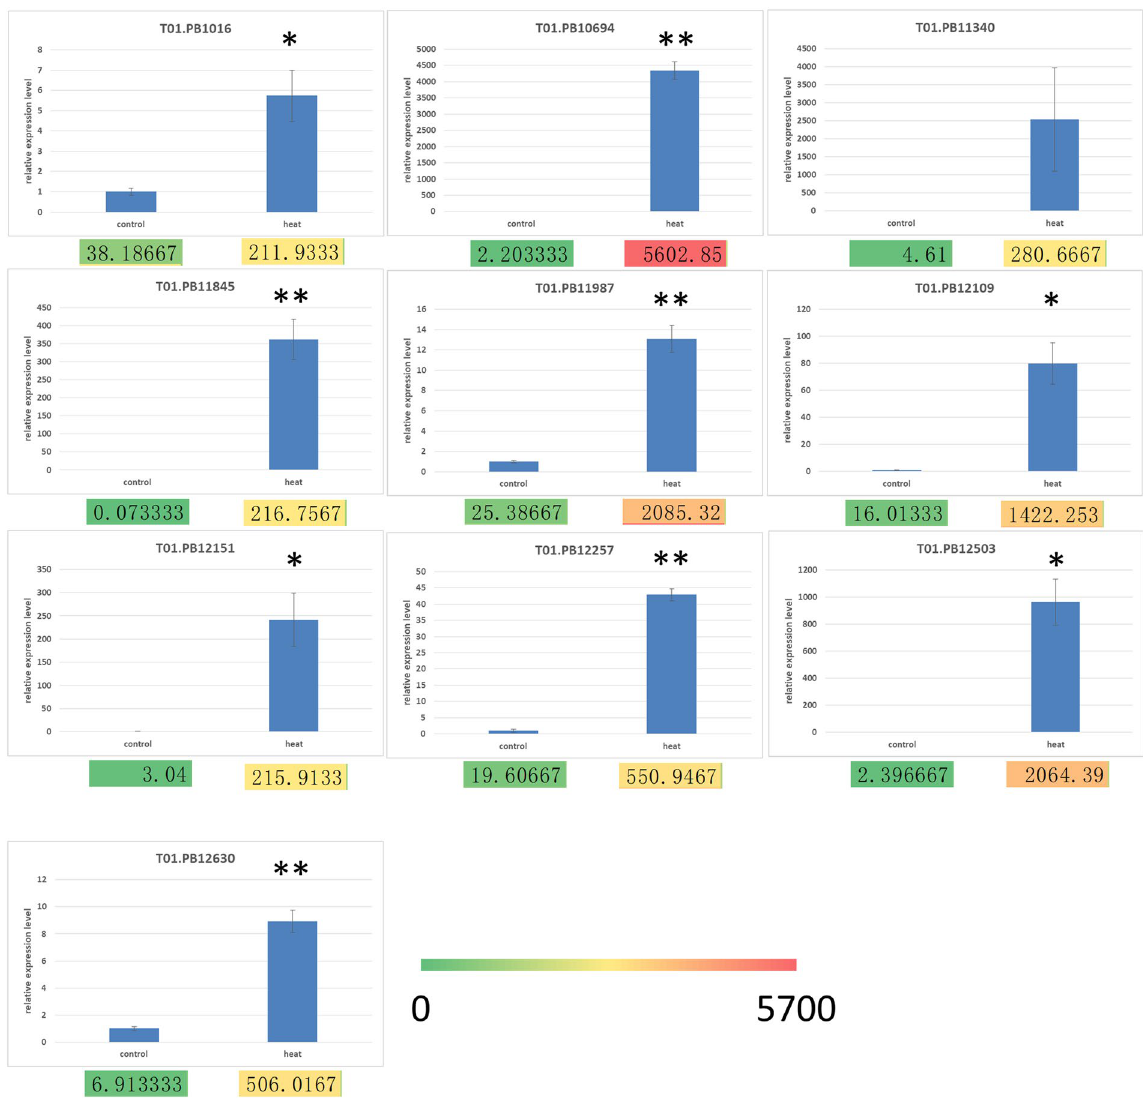
Figure 7. qRT-PCR validation of differentially expressed genes in Z . japonica under heat stress. Expression levels were normalized to the reference gene actin . Error bars indicate standard deviations of the three biological replicates. The statistical difference between means is indicated as * P < 0.05 or ** P < 0.01. Colors and numbers under the bar charts refer to the FPKM of